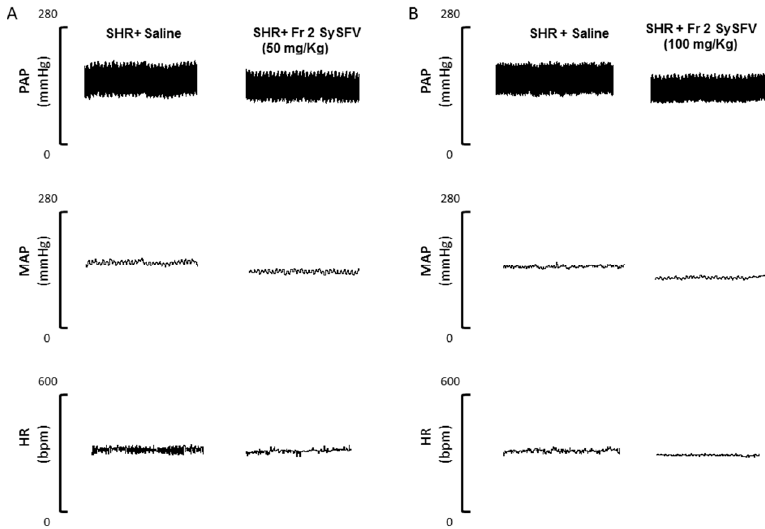
Figure 2. Representative tracings illustrating the changes in pulse arterial pressure (PAP, mmHg), mean arterial pressure (MAP, mmHg) and heart rate (HR, bpm) in spontaneously hypertensive rats (SHR) pretreated with Fr 2 SySFV at 50 mg/kg ( A ) and 100 mg/kg ( B ) p.o. and in saline-treated controls.